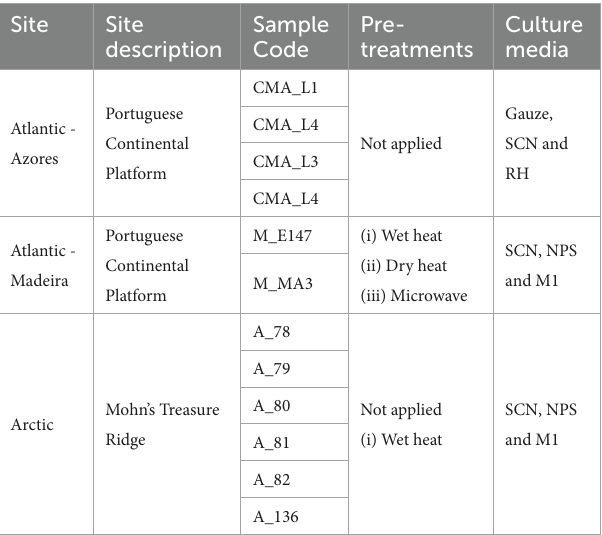
TABLE 2 Pre-treatments and culture media used for the isolation of actinobacteria from the deep-sea